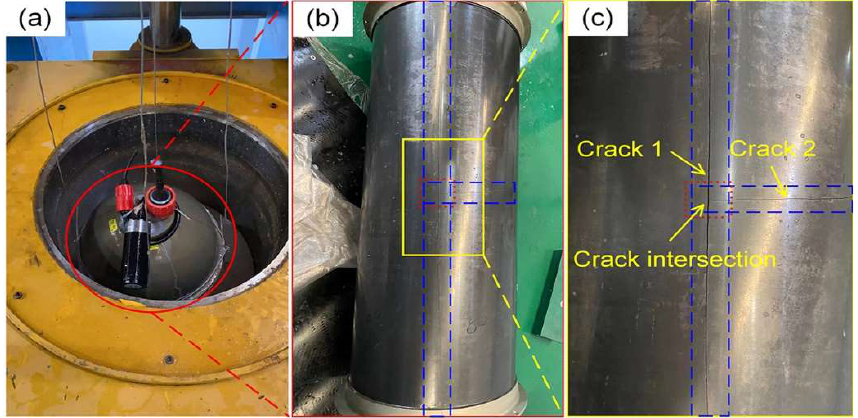
Figure 11. Hydrostatic pressure experiment for the SiC&7075-T6 ceramic pressure housing. ( a ) The SiC&7075-T6 ceramic pressure housing loaded into the high-pressure chamber; ( b ) Failed pressure housing; ( c ) Partial view of the failed pressure housing with two